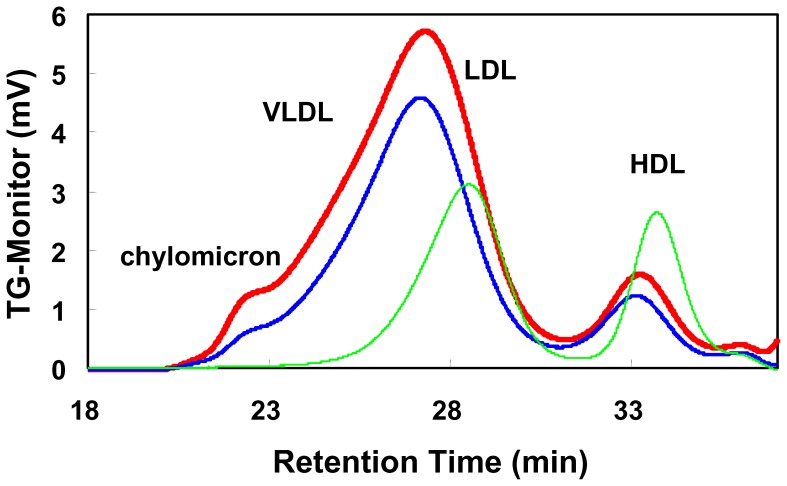
Serum TG analysis by HPLC.Lipoproteins in 10 week treatment serum samples were analyzed by HPLC. The mean value of the control group is shown by a red line and the cilostazol group by the blue line and the normal diet group by the green line. Control [n = 5], cilostazol [n = 5], normal diet [n = 3].